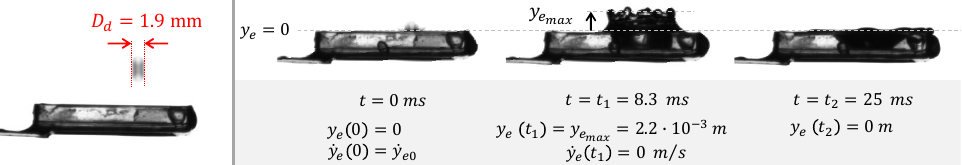
Figure 16. Footage of the experimental test of a drop impacting on the wet spoon and corresponding parameters needed for the force model determination.